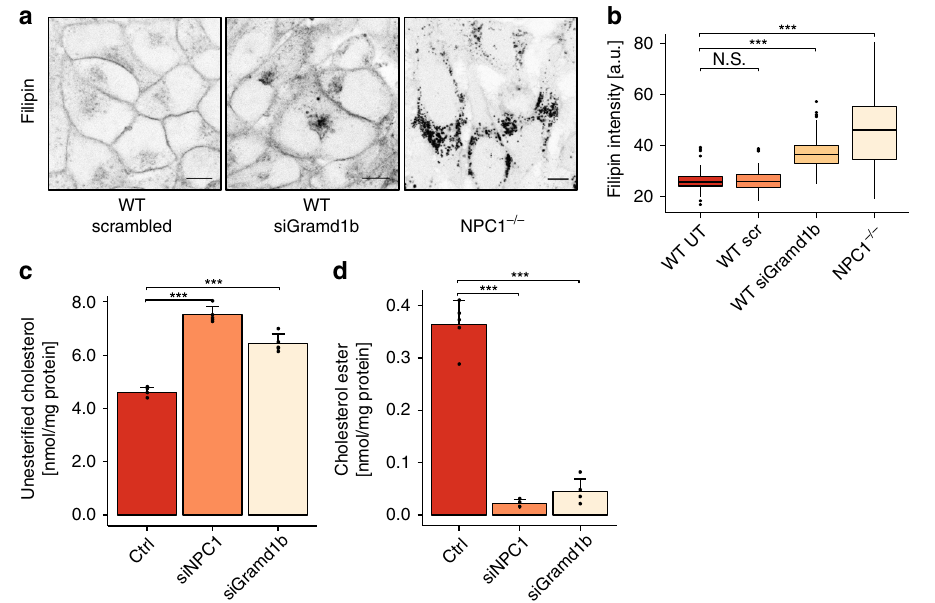
Fig. 3 NPC1-regulated MCSs mediate cholesterol transport from late endocytic organelles to the ER. a Confocal microscopy images of WT HeLa cells transfected with control (scrambled) or Gramd1b siRNA as well as NPC1 − / − HeLa cells stained with 50 µ g/mL Filipin. Scale bars,10 µ m. b Quanti fi cation of Filipin intensity in cells treated as described in a . Boxplots show medians as centre lines, box limits indicate fi rst (Q1) and third quartiles (Q3), whiskers are at a maximum distance of 1.5*IQR (interquartile range) from Q1 and Q3, respectively or to the most extreme datapoint within that range. Outliers are shown. Welch two sample t-tests were performed between untreated WT condition and treatment conditions: WT-scrambled ( n = 95 cells), WT- siGramd1b ( n = 101 cells), NPC1 − / − ( n = 43 cells). N.S. P = 0.6216, *** P < 2.2 × 10 − 16 , *** P = 4.9 × 10 − 11 . c Quanti fi cation of unesteri fi ed cholesterol in HeLa cells treated with non-targeting control (ctrl), NPC1 and Gramd1b siRNAs. Cholesterol was measured using the Amplex Red Cholesterol Assay Kit and values are presented as mean of fi ve independent experiments + SD. Welch two sample t-tests were performed between all conditions. ctrl/siNPC1 *** P = 0.00063, ctrl/siGramd1b ** P = 0.00389, siNPC1/siGramd1b ** P = 0.0085. d Quanti fi cation of cholesterol esters in HeLa cells treated with control, NPC1 and Gramd1b siRNAs. Cholesterol esters were measured using the Amplex Red Cholesterol Assay Kit with addition of 0.2 U/mL cholesterol esterase. Data are represented as mean of fi ve independent experiments + SD. Welch two sample t -tests were performed between all conditions.